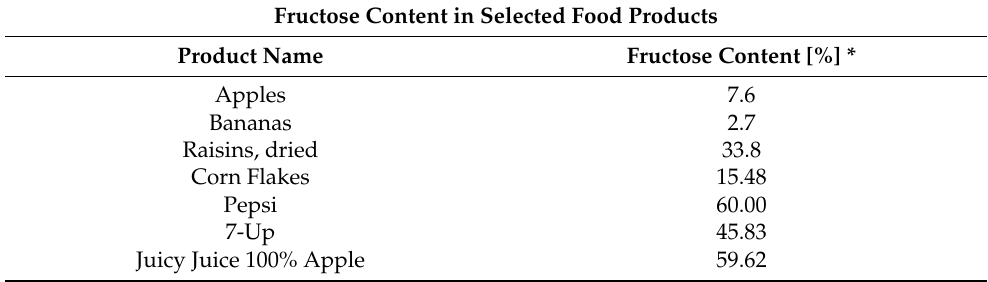
Table 4. Fructose content in selected food products based on [81–83].